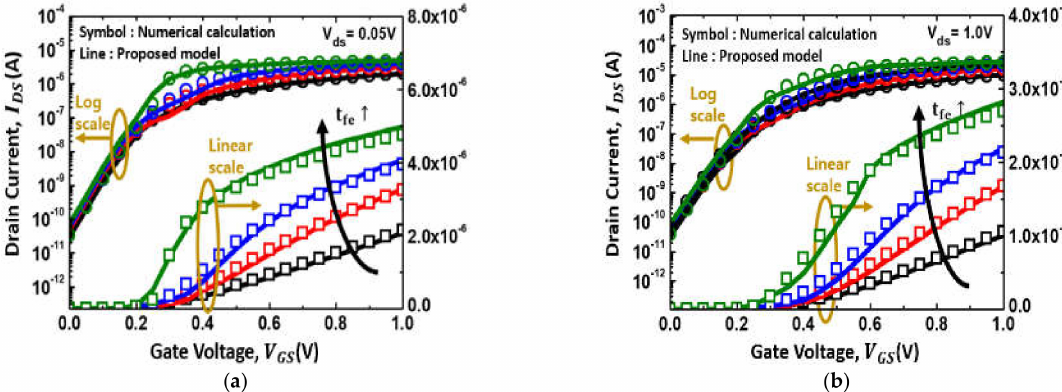
Figure 4. Comparison of drain current versus gate-to-source voltage between proposed model and numerical calculation when ferro-electric thickness varies with t fe = 0, 3, 5, and 8 nm (R = 10 nm, t ox = 1 nm); ( a ) low drain bias; ( b ) high drain